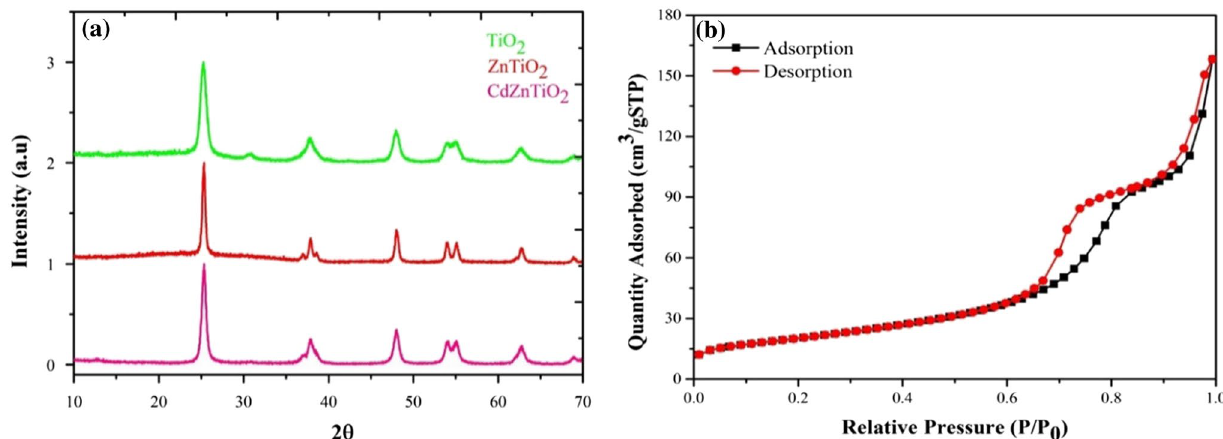
Fig. 4 a XRD spectra of TiO 2 , ZnTiO 2 and CdZnTiO 2 , b BET and adsorption desorption plot for CdZnTiO 2 Table 1 The specific surface area, pore volume and pore size of ZnCdTiO 2 nanocomposite